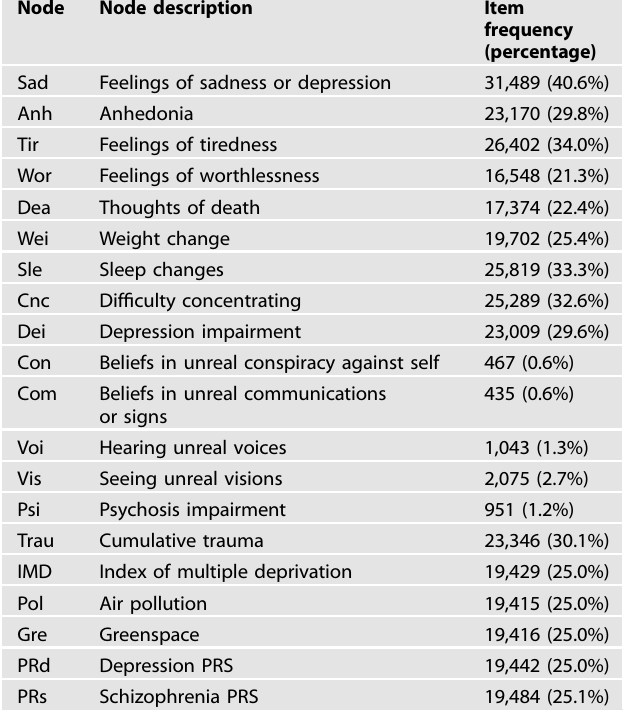
Table 1. Node labels and node descriptions used in estimated networks, along with item